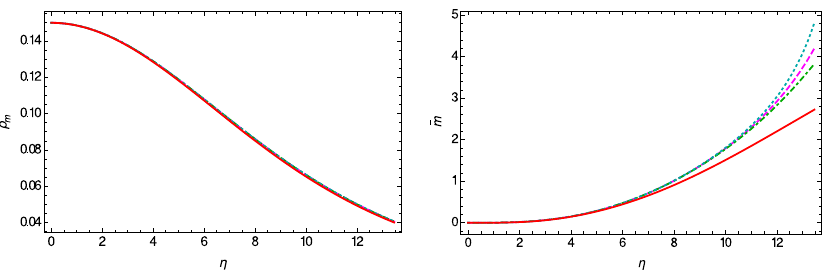
(dot-dashed curve). For the central density of the star we adopt the value ρ mc = 3 . 7 × 10 14 g / cm 3 . The solid curve represents the standard general relativistic density and mass profiles for stiff-fluid stars